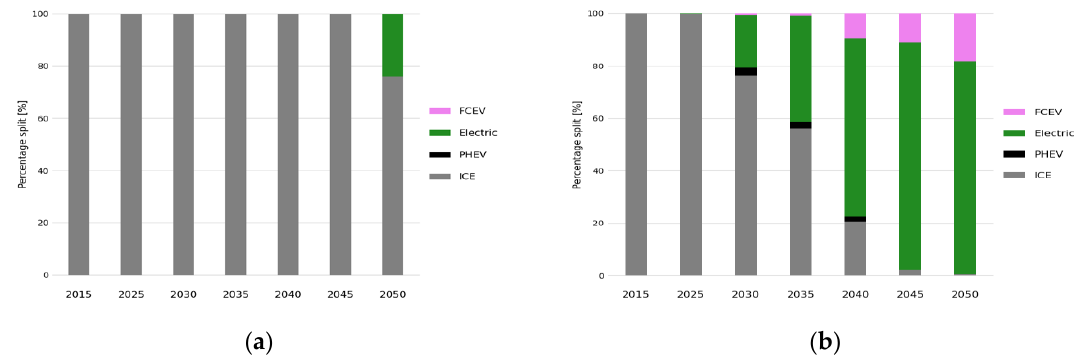
Figure 7. Passenger road vehicle mix over time for different scenarios (represented in terms of share in total